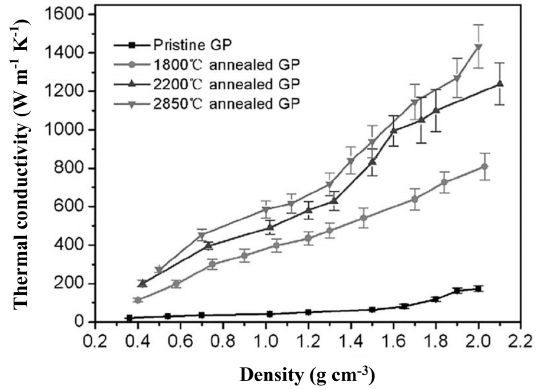
Figure 8. Change of thermal conductivity of free-standing graphene films with different density under different annealed temperatures. Reprinted with permission from [40]; Copyright 2014 Wiley Online Library.